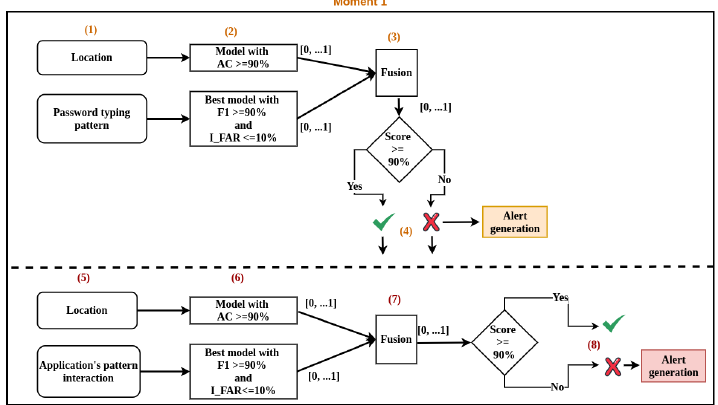
Figure 1. Proposed